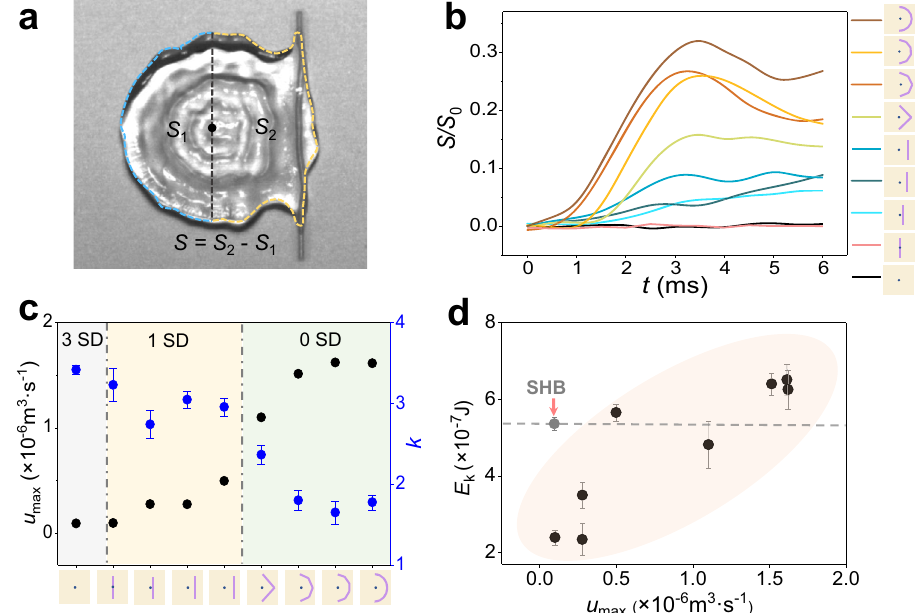
Fig. 3 Effect of the liquid fl ow on the satellite drop number, elongation length and the main droplet kinetic energy. a The de fi nition of area S at time t . b Changes of the area S/S 0 with time t on different wettability surfaces. c Changes in the maximum net liquid fl ow rate u max , satellite drop number and k (de fi ned as the ratio of droplet elongation length and droplet diameter D ) on different wettability surfaces. d The in fl uence of the maximum net liquid fl ow rate u max on the kinetic energy of the main droplets E k . The error bars of the data in c , d are obtained from the s.d. of 5 independent experiments.